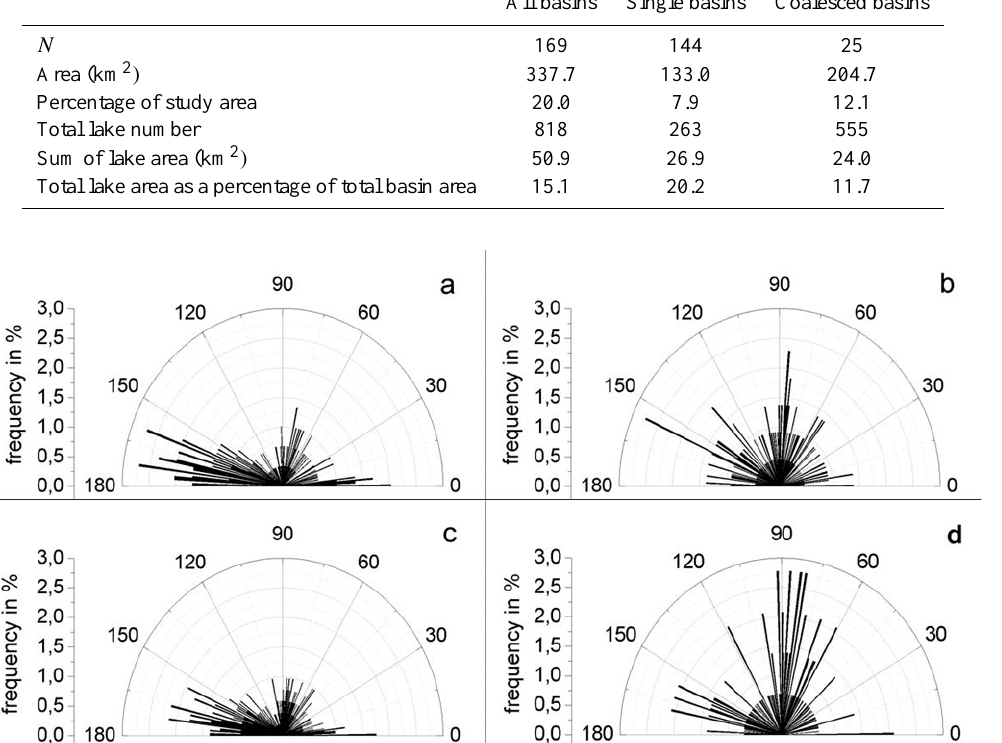
Fig. 6. Frequency distribution of major axis orientation for (a) lakes ≥ 14400m 2 on Yedoma uplands, (b) lakes ≥ 14400m 2 in basins, (c) all lakes ≥ 14400m 2 , and (d) single basins. Intervals=1 ◦ , 0 ◦ =East, 90 ◦ =North, 180 ◦